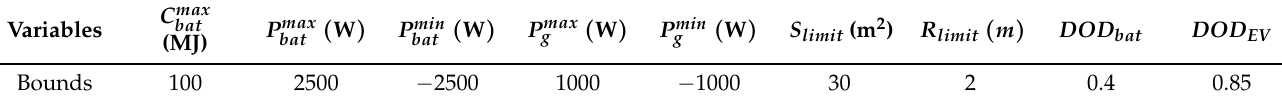
Table 2. Decision variables